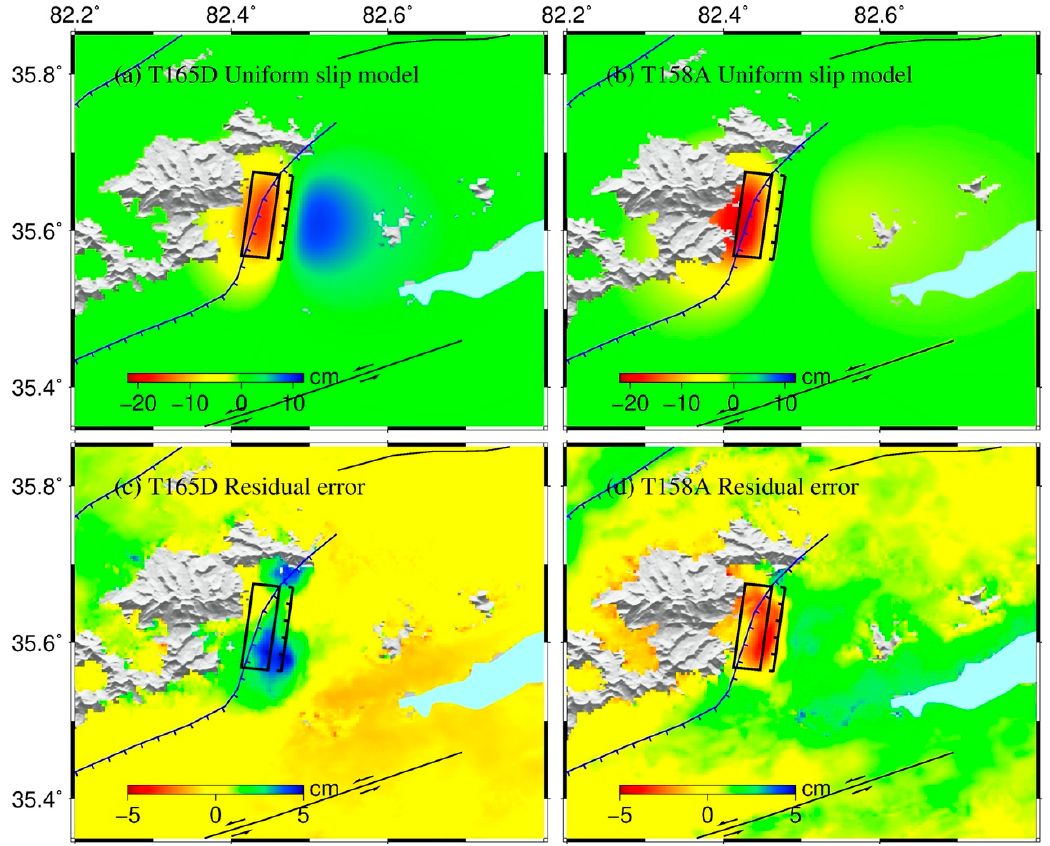
Figure 8. ( a,b ) Synthetic and ( c,d ) residual displacement for interferograms of T165 and T158A, based on the optimal uniform slip model in Table 3. The black line indicates the fault line projected on the surface along its dip plane upward, and the black rectangular frame is the uniform slip plane in the subsurface.